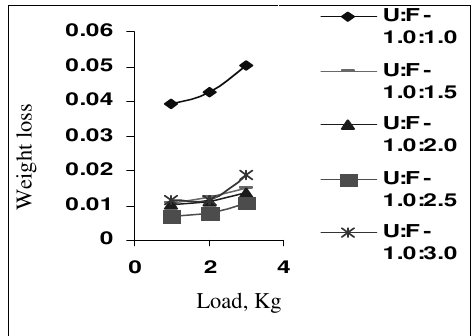
Figure 5. Wear resistance of UF resin